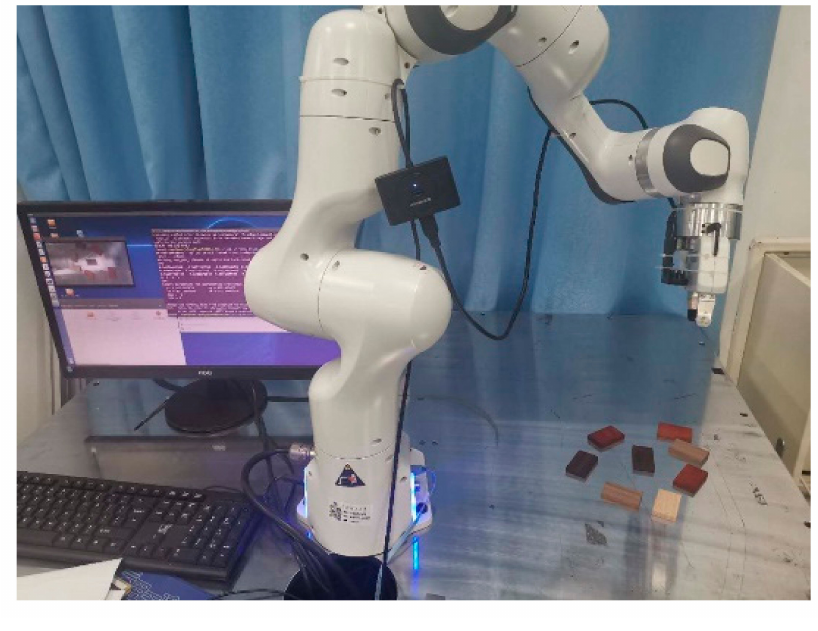
Figure 8. Experimental platform.